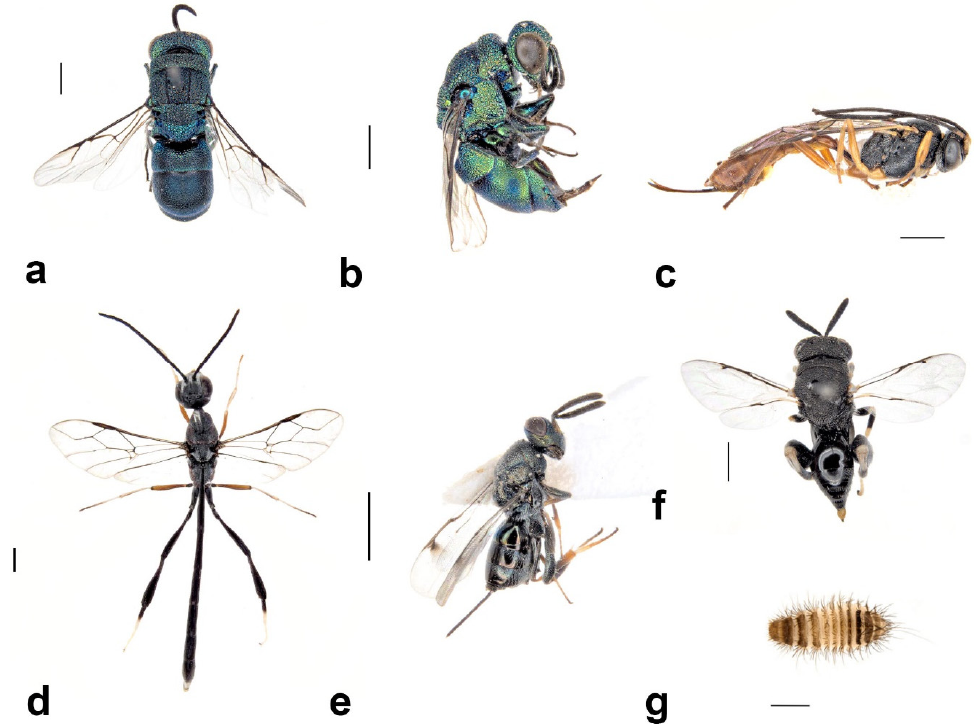
Figure 13. Group 4, Adult parasitoids of the secondary tenants ( a – e ), and Group 7, the Scavenger ( f ): ( a ) dorsal view of P. reversus; ( b ) lateral view of P. faustus ; ( c ) lateral view of Phrudus sp.; ( d ) dorsal view of male G. cinerescens; ( e ) lateral view of Toryminae wasp; ( f ) dorsal view of Brachymeria sp.; ( g ) dorsal view of Anthrenus larva. Scale bar = 1